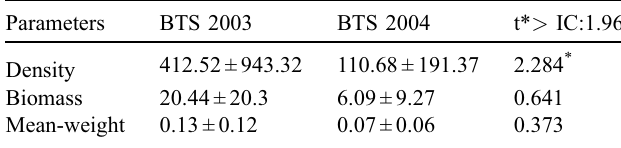
Table 1. Total mean density (ind/km 2 ), total mean biomass (kg/km 2 ) and total mean weight (kg) of P. blennoides caught from bottom trawl surveys (BTS) along the Algerian coast.* Signi fi